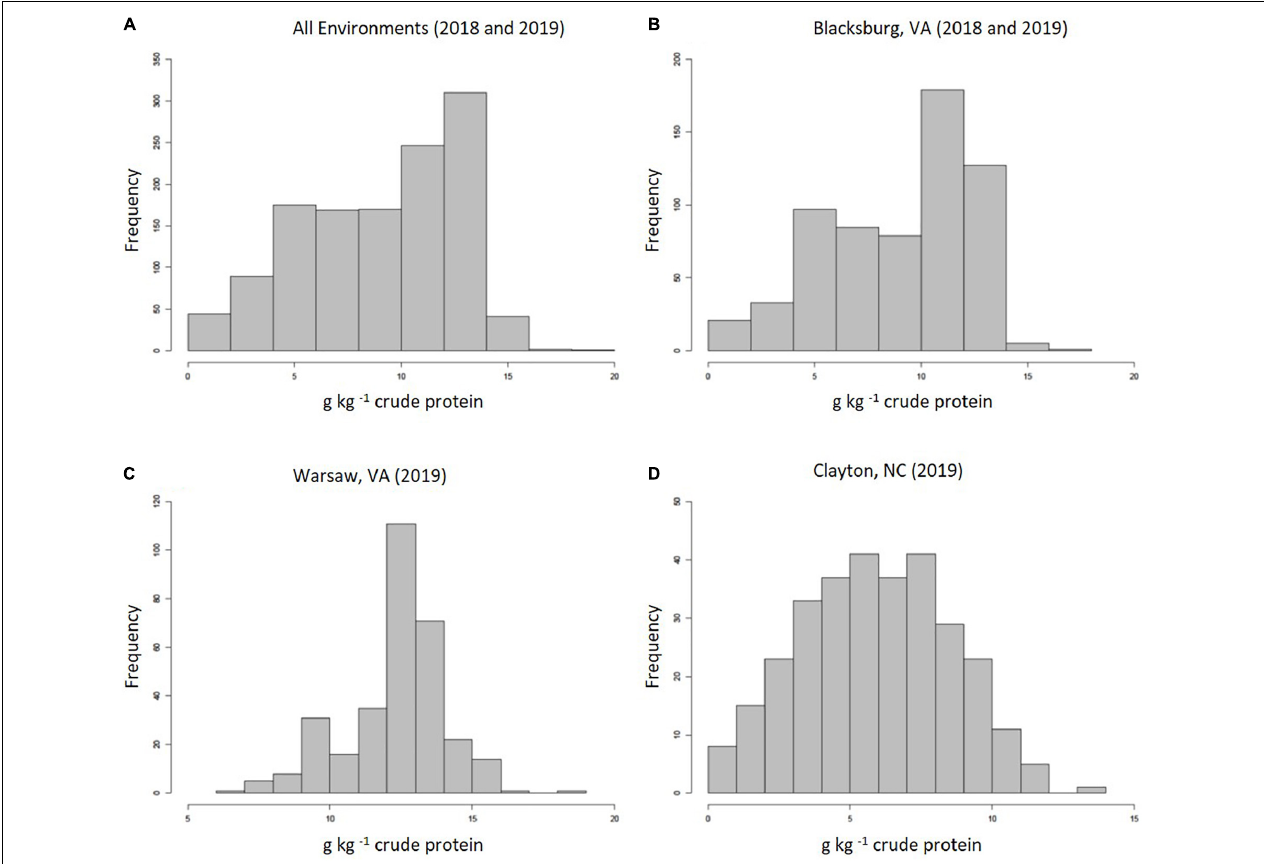
FIGURE 1 | Frequency distributions displaying proteinogenic Met concentrations collected from all environments (A) , Blacksburg, VA (B) , Warsaw, VA (C) , and Clayton, NC (D)